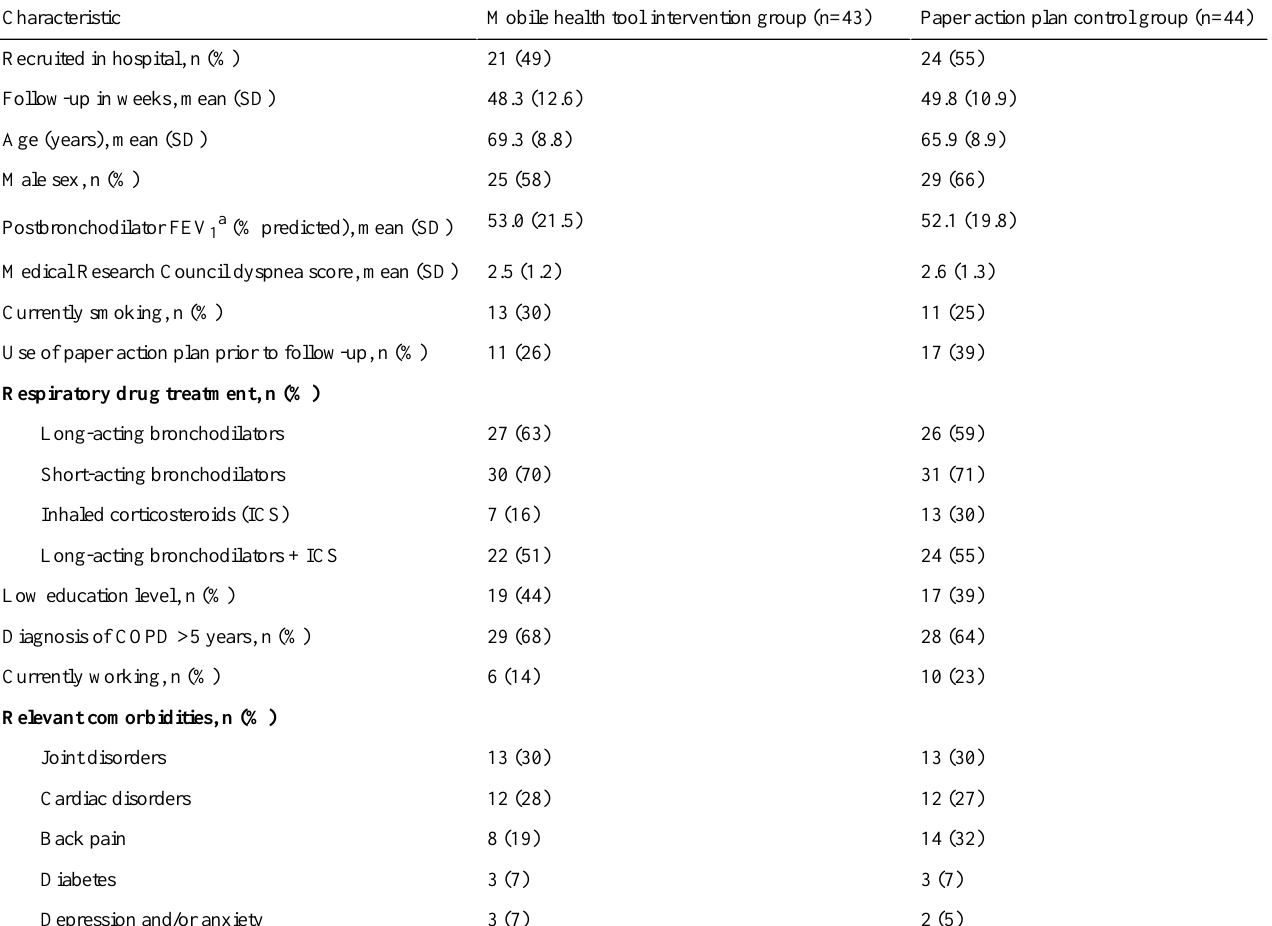
Table 1. Baseline and demographic characteristics of the study population (N=87) per treatment arm.